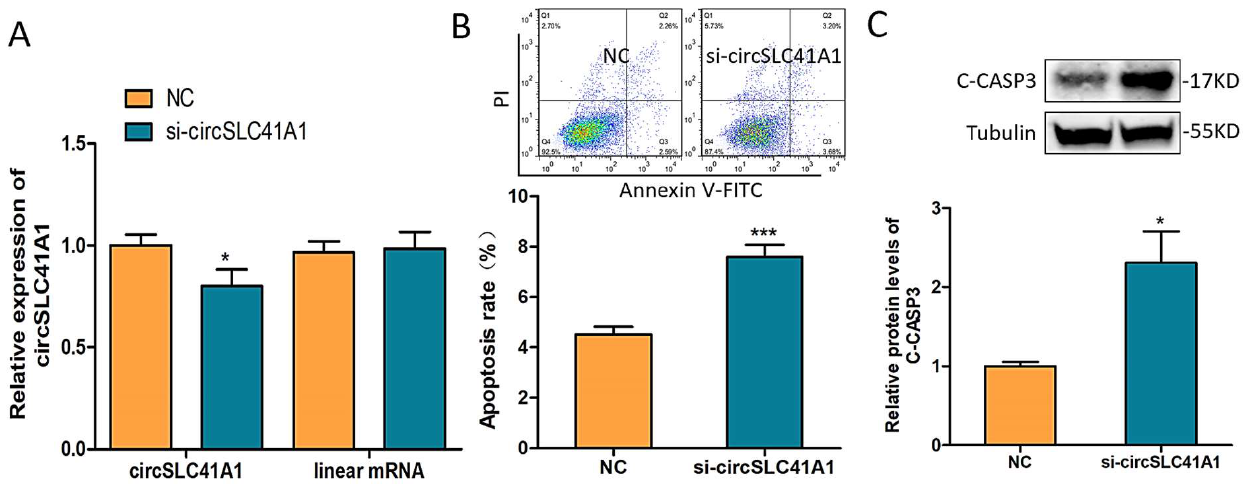
Figure 2. circSLC41A1 inhibits GCs apoptosis. ( A ) Expression of circSLC41A1 and its corresponding linear mRNA in GCs treated with siRNA control (NC) or si−circSLC41A1 RNA detected by qRT- PCR. ( B ) The apoptosis rate of GCs after circSLC41A1 knockdown examined by Annexin V−FITC/PI staining assay using flow cytometry at the top of panel B. ( C ) Protein levels of cleaved CASP3 after circSLC41A1 knockdown were analyzed by western blot. Data are expressed as the mean ± SEM of three experiments; * p < 0.05, ***p<0.001.